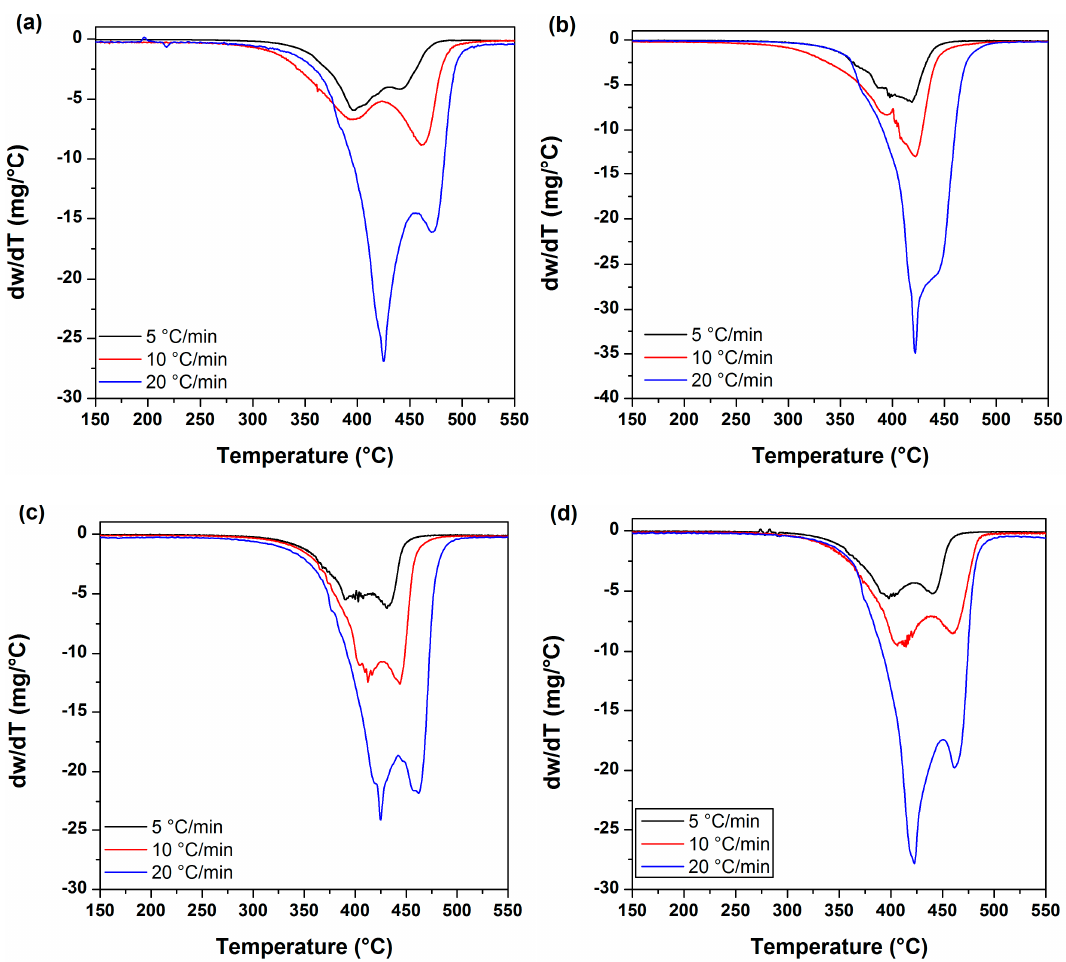
Figure 6. DTG plots from UPR and nanocomposites obtained at a heat rate of 5, 10 and 20 °C/min for: ( a ) UPR, ( b ) UPR/ZnO400, ( c ) UPR/ZnO500 and ( d )